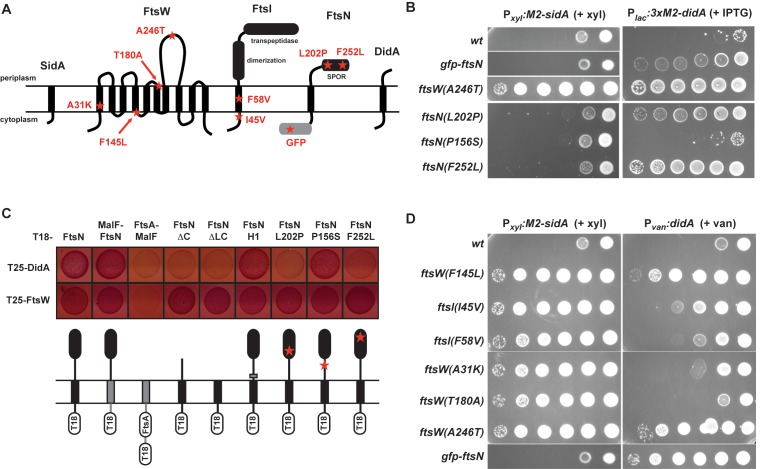
Mutations in the FtsW/FtsI/FtsN complex suppress SidA and DidA overproduction phenotypes.(A) Schematic showing the membrane topology of FtsW, FtsI, FtsN, SidA, and DidA. Missense mutations and the GFP-FtsN fusion that suppress the activities of SidA or DidA, or both, are listed in red. (B) Strains harboring the mutations indicated were transformed with a medium-copy plasmid expressing M2-sidA from the Pxyl promoter or a low-copy plasmid expressing 3×M2-didA from the Plac promoter. To induce M2-sidA, strains were grown in media supplemented with glucose and then plated on media supplemented with xylose. To induce 3×M2-didA, strains were grown in media without inducer and then plated with IPTG. Each strain was plated in 10-fold dilutions. (C) Bacterial two-hybrid analysis of interactions between T25-DidA or T25-FtsW and T18 fusions to FtsN and the mutants indicated. Below is a graphical representation of each T18 construct. (D) Strains harboring the mutations indicated were transformed with plasmids for inducing M2-SidA or DidA and plated on inducing media.